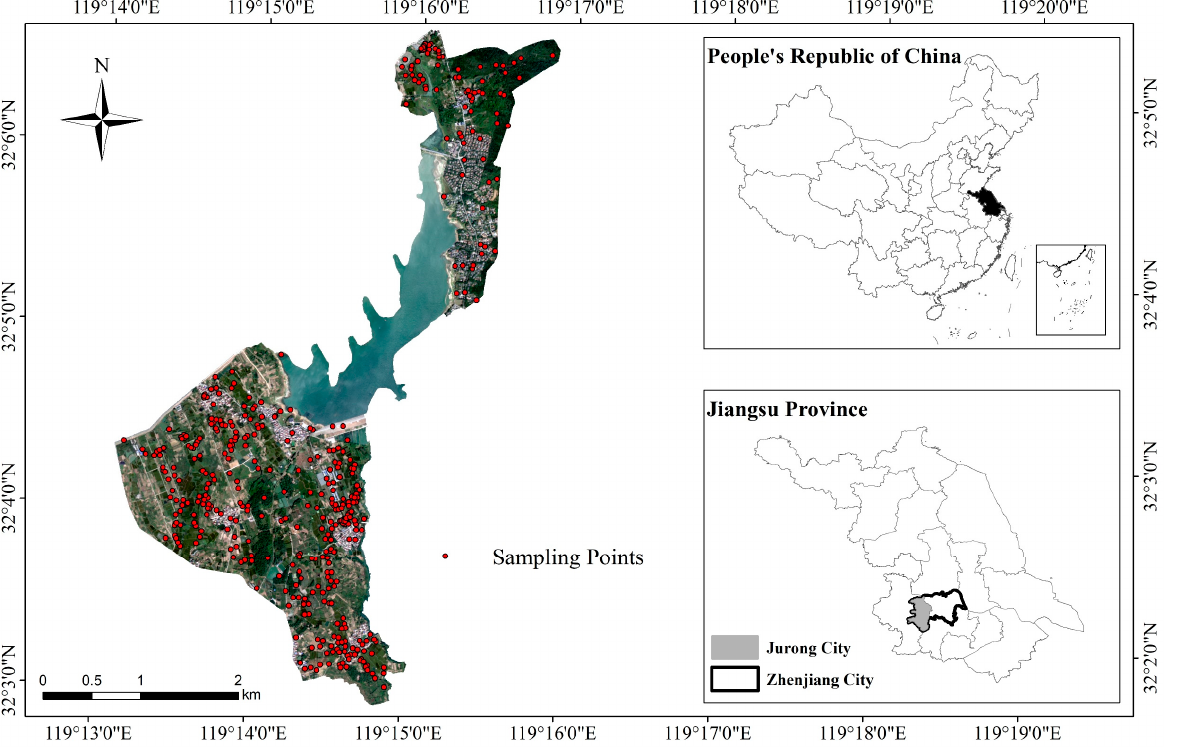
Figure 1. Map of the study area and sampling points distribution.